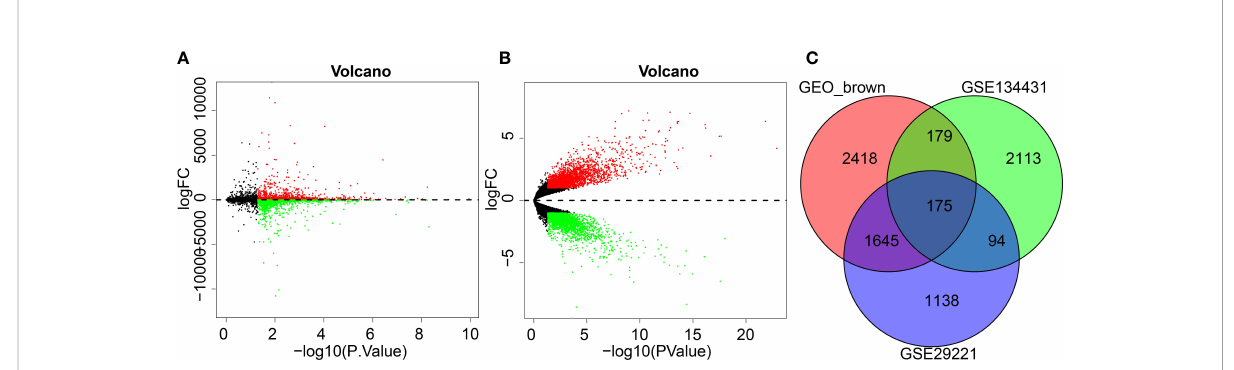
FIGURE 3 GEO differential analysis for screening DFU-related DEGs. (A) , Volcano map of GSE29221 dataset (Black color represents genes not differently expressed, red color represents up-regulated genes and green color represents downregulated genes). (B) , Volcano map of GSE134431 dataset (Black color represents genes not differently expressed, red color represents up-regulated genes and green color represents downregulated genes). (C) , Venn diagram shows brown modules obtained from intersection of DEGs in GSE134431 and GSE29221 datasets.